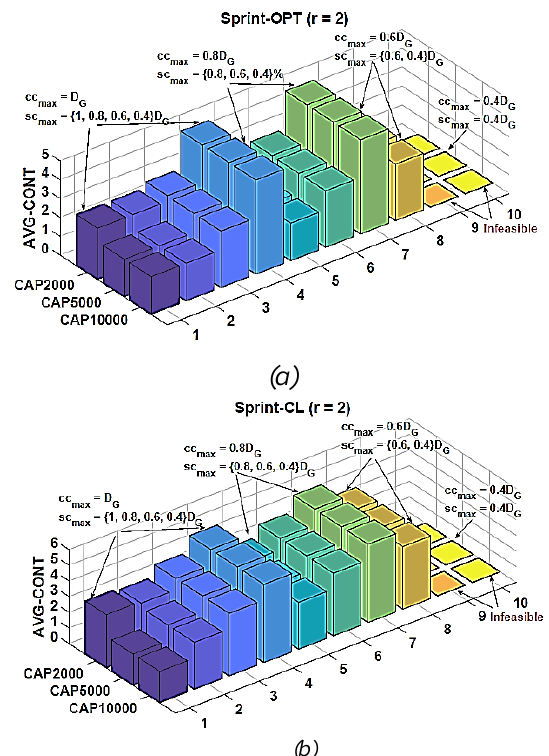
Figure 3. Impacts of controllers capacity, ccmax, and scmax on the average number of required controllers (the numbers on the x-axis correspond to different